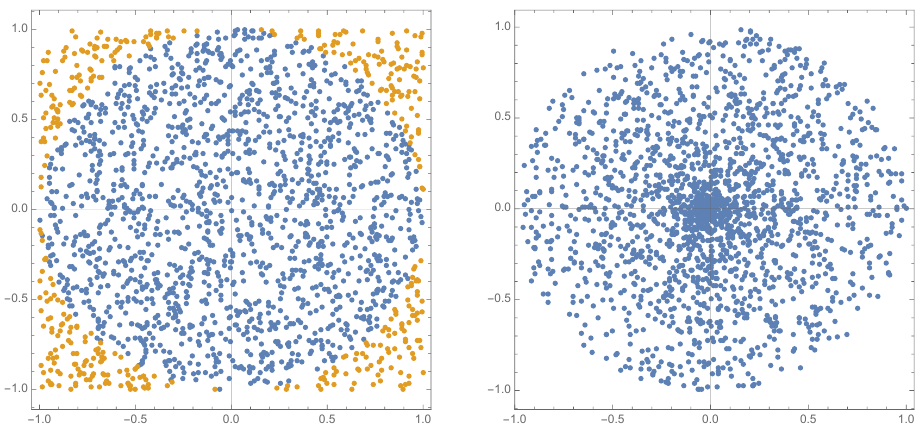
Figure 8 . Illustration of rejection sampling ( left ) and how the induced measure for sampling spherical coordinates with a flat prior can be non-flat ( right ) using the example of the unit disk.